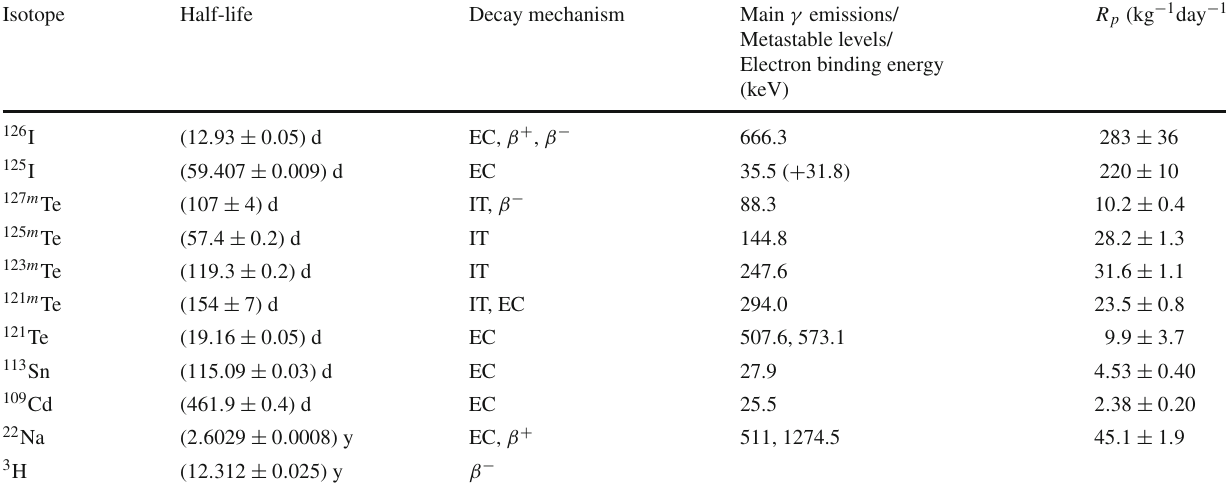
trons for EC decays. Decay information for 125 I, 127 m Te, 123 m Te, 113 Sn, 109 Cd, 22 Na and 3 H has been taken from Ref. [56] and for the other iso- topes from Ref. [57]. The last column presents the production rates R p at sea level derived for each isotope from ANAIS data (see text)